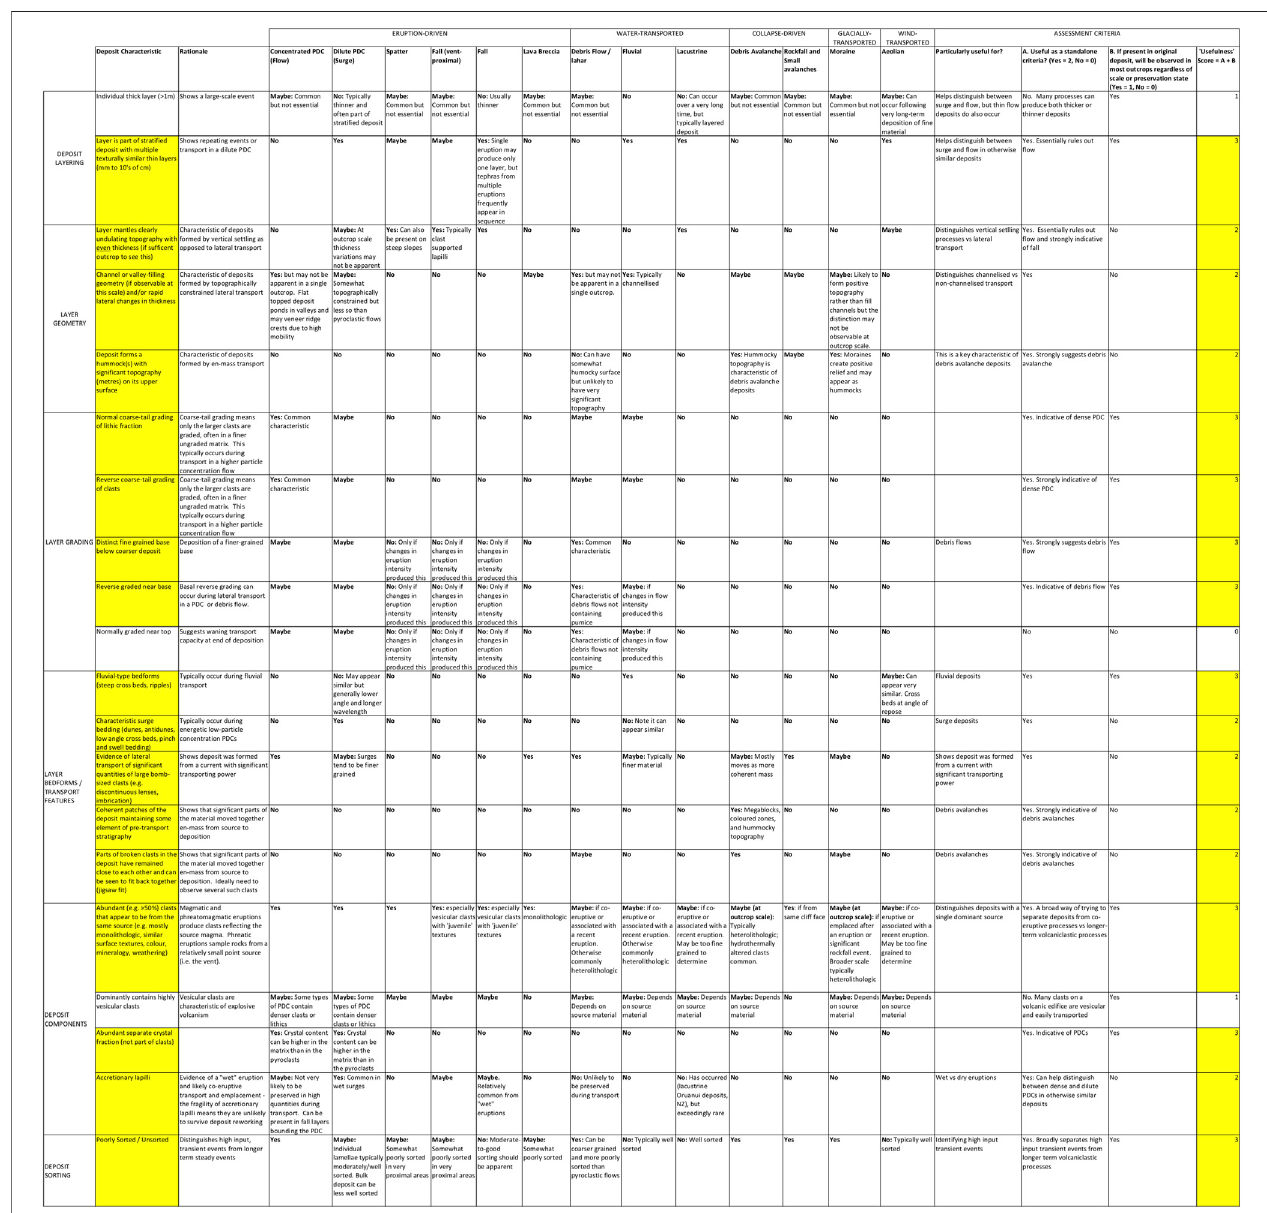
FIGURE 2 | Key deposit characteristics resulting from most common volcaniclastic processes. Criteria are assessed on their usefulness as standalone criteria for identifying particular volcaniclastic processes (scored from 0to 2), and on their abilityto be observed in any deposit (scored from 0 to1). Highlighted criteria, including